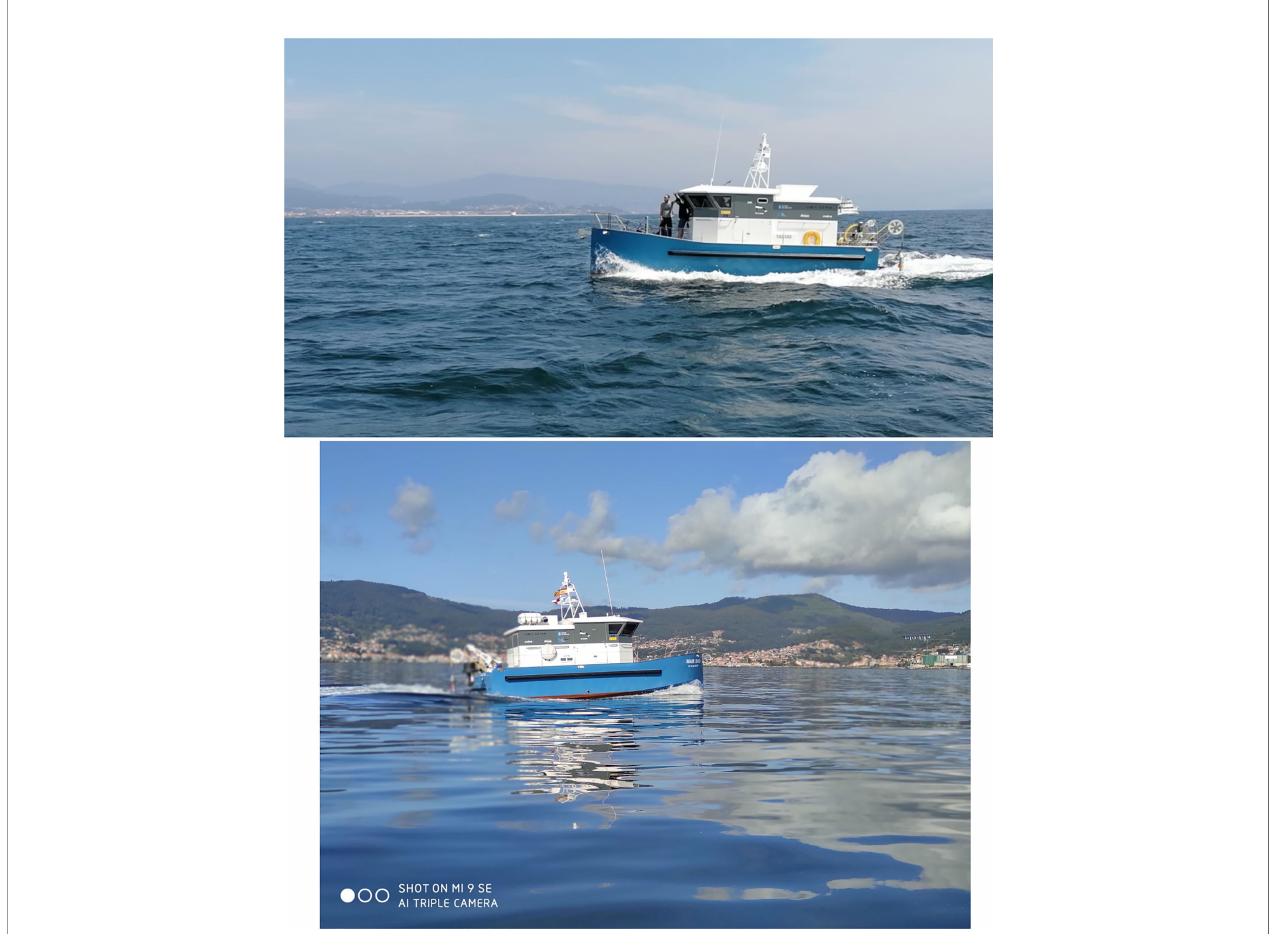
FIGURE 11 | The USV Mar II prototype, developed in the Galician CIVIL UAV Initiative for Automatic oceanographic sampling, operating in the Galician Rias in manned and unmanned mode. Pictures provided by GAIN, Xunta de Galicia,